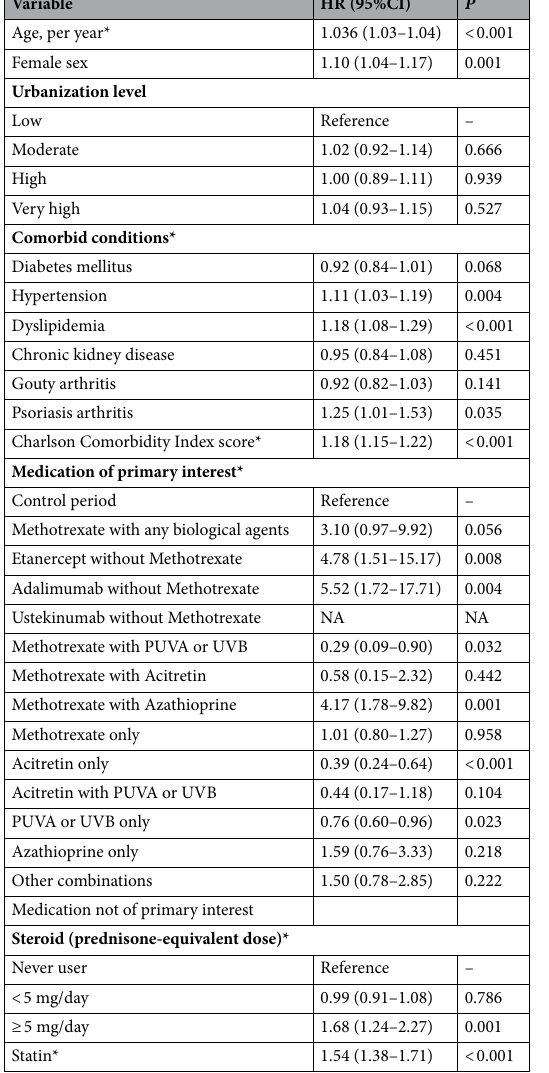
Table 3. Associations between covariates, medications, and risk of herpes zoster. PUVA photochemotherapy, UVB ultraviolet B, HR hazard ratio, CI confidence interval, NA not applicable. *Time-varying covariates that may change in each